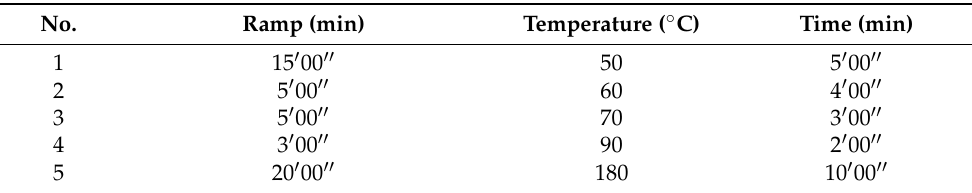
Table 2. Instrumental conditions of the microwave digestion